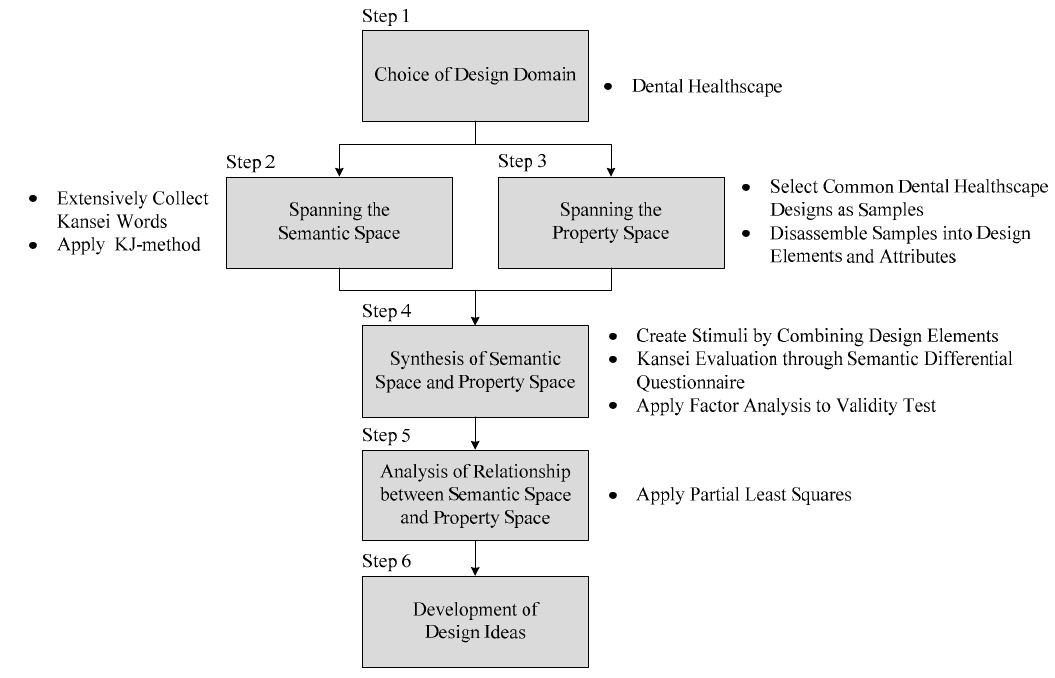
Figure 3. Proposed Kansei engineering (KE)-based approach.